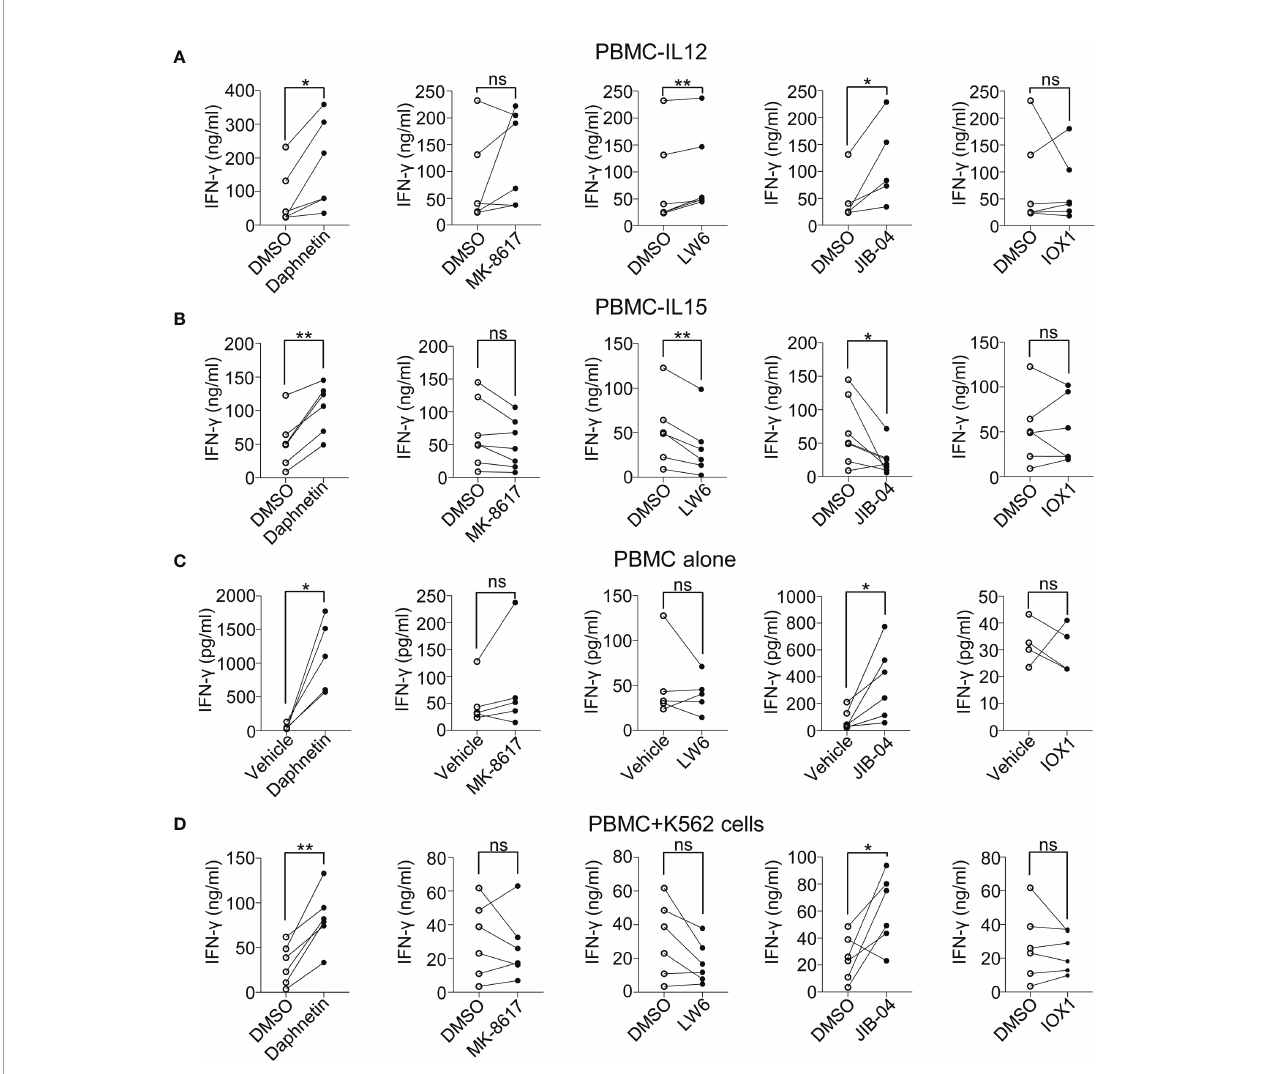
FIGURE 2 | Effects of the fi ve identi fi ed candidates on IFN- g secretion in the supernatants of cultured PBMCs. (A – C) Healthy donor PBMCs were treated with DMSO or the identi fi ed fi ve candidates for 18 h in the presence of IL-12 (10 ng/ml) (A) , IL-15 (10 ng/ml) (B) , or in the absence of IL-12 or IL-15 (C) , respectively. The protein levels of IFN- g in the supernatants of cell culture were detected by ELISA kit. (D) Healthy donor PBMCs were pre-treated with DMSO or indicated candidates in the presence of IL-12 (10 ng/ml) for 18 h, and co-cultured with K562 cells for another 6 h IFN- g secretion in the supernatants was detected by ELISA kit. Each dot represents one donor. Paired t -test for (A – D) . * p < 0.05, ** p < 0.01, and ns (not statistically signi fi cant) denote statistical comparison between the two marked treatment groups (A – D)